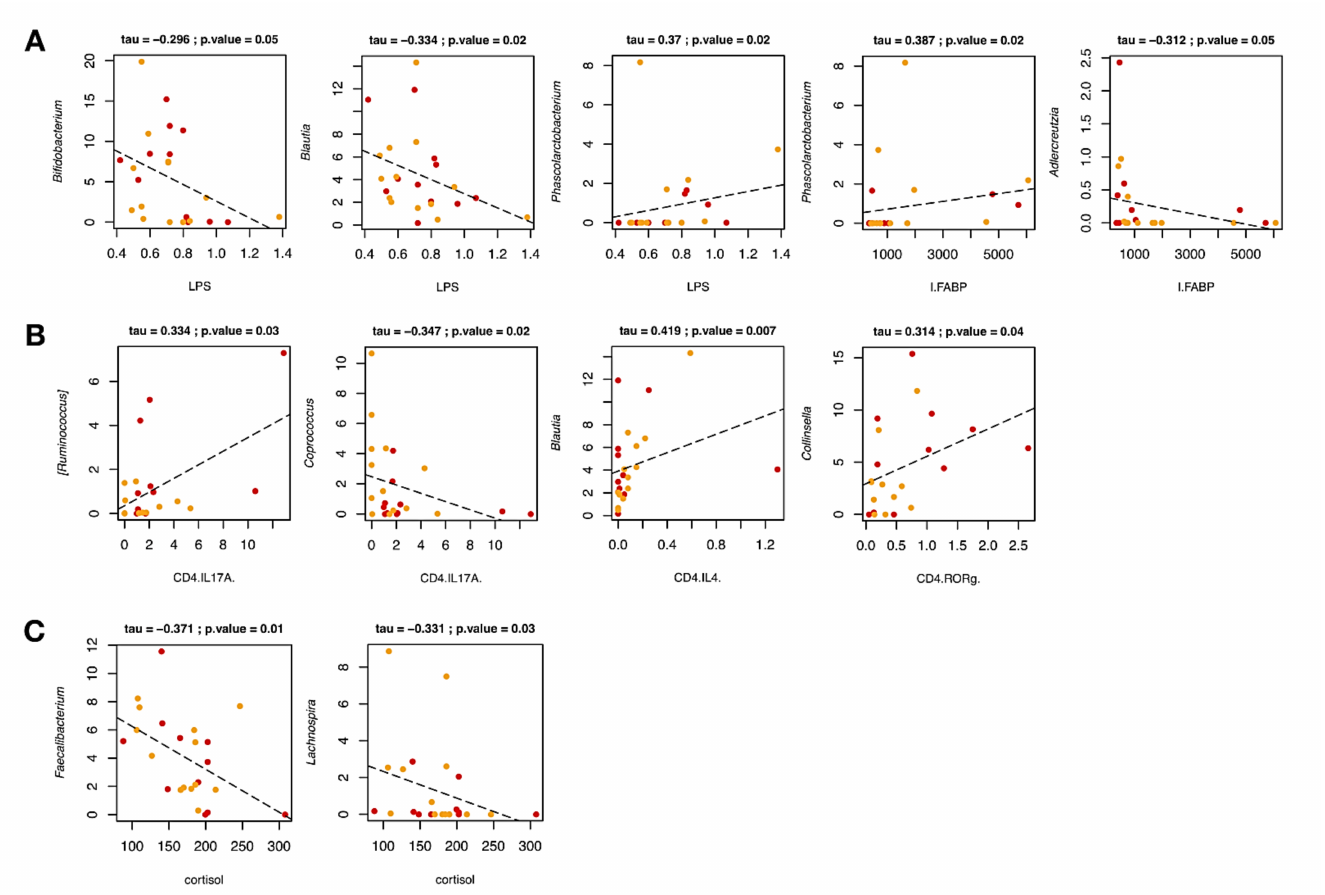
Figure 3. Associations between genus-level relative abundances and levels of LPS and I-FABP ( A ), lymphocytes subpop- ulations ( B ), and cortisol ( C ) in multiple sclerosis patients over the rehabilitation program. Only statistically significant correlations ( p ≤ 0.05) with an absolute Kendall rank correlation coefficient ≥ 0.3 for genera with relative abundance ≥ 1% are